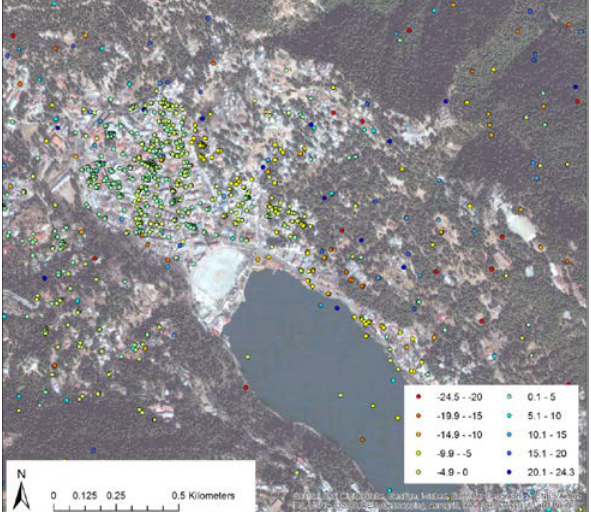
Figure 6: Mean velocity map for the EnviSAT Track 248 image stack for Nainital processed with PSInSAR. Background data: Esri, DigitalGlobe, GeoEye, i-cubed, USDA, USGS,